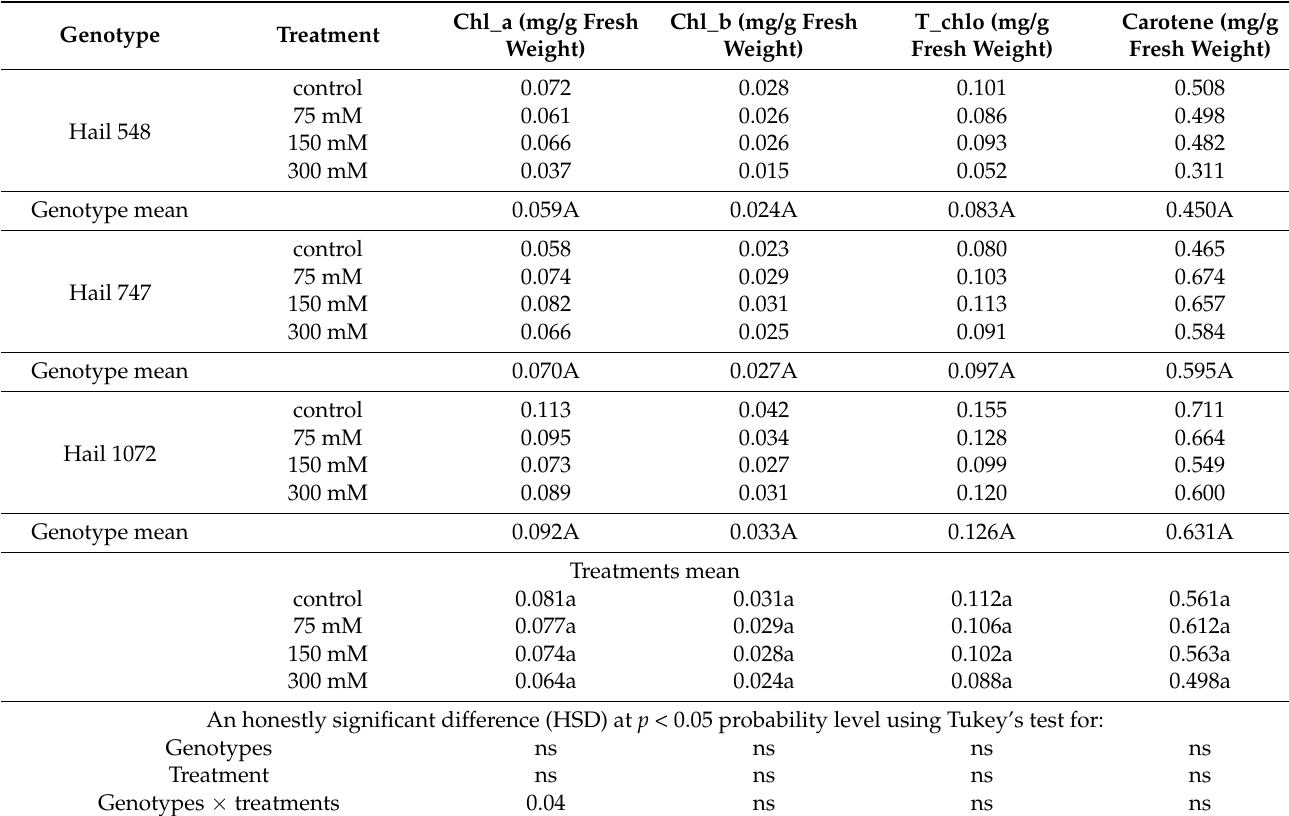
Table 2. Mean values of chlorophyll-a, chlorophyll-b, total chlorophyll, and carotenoid for three Hail landraces under four NaCl stress treatments. Values are the mean of four replications. According to Tukey’s test, different letters within the same columns indicate significant differences ( p < 0.05). The higher cases are the differences among genotypes, and the lower cases are the differences among treatments’ mean. ns: means not significant. Chl_a: chlorophyll-a; Chl_b: chlorophyll-b; T_chlo: total